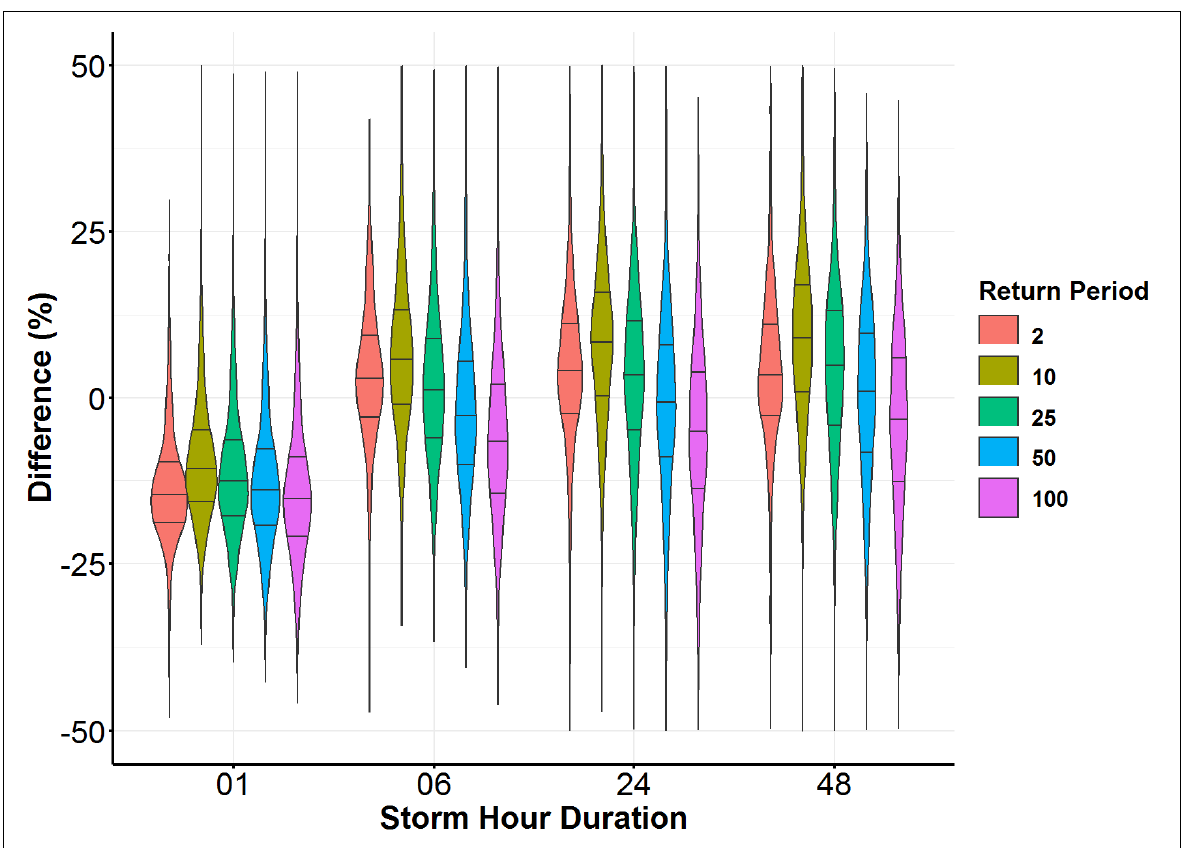
Figure 9. The distribution of the difference for all the storm durations and return periods across the state of Texas (Difference = (NEXRAD IDF value − NOAA Atlas 14 value)/NOAA Atlas 14 value). The spatial distribution of the differences shows an overestimation by radar over the majority of the panhandle (north) and big bend (west) regions of the state and an under- estimation over the southcentral areas for all storm durations (Figure 10). A comparison of the values for the 1-h duration 100-year return period storms shows underestimation over 90% of the state. Overestimation can only be seen in the northern and western regions (Figure 10A). Areas with a difference within ± 10% for the 1-h storm duration for the 100-year return period cover about a quarter of the state. However, the area within a ± 10% difference covers more than 50% of the state in the case of the 6-h, 24-h, and 48-h storm durations for the same return period. The average differences for the 24-h and 48-h storm durations are very similar, within ± 1% for all return periods. This suggests that the IDFs for longer storm durations are almost the